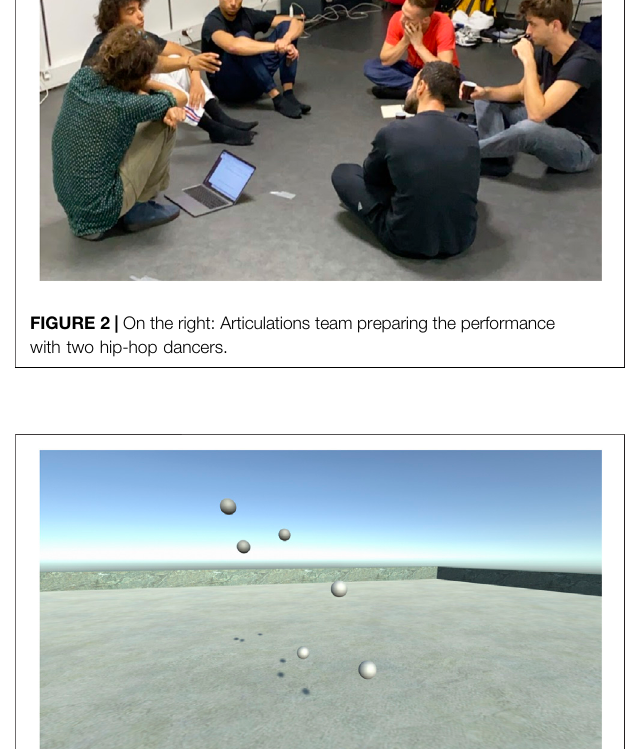
FIGURE 3 | Third-person point of